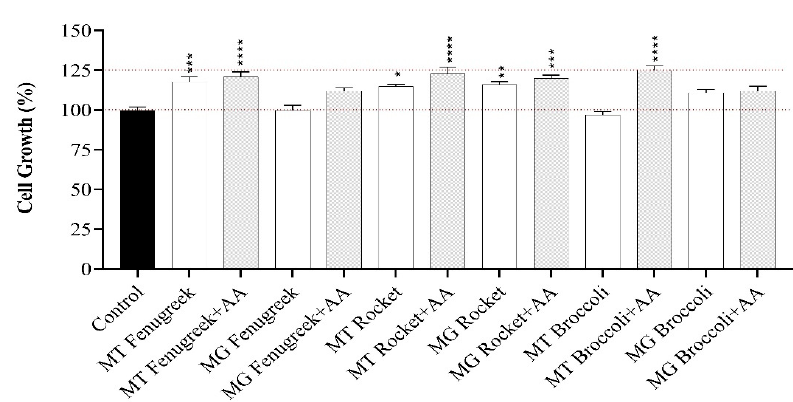
Figure 1. Cell viability of Caco-2 after exposure to digest vegetable Mature (MT) and Microgreen (MG) samples alone or with added ascorbic acid (AA) during digestion for 2 h. Results are presented as means ± SEM, n = 4. Data were analysed using a one-way ANOVA test. Different letters on top of bars indicate a significant difference: * ( p ≤ 0.05), ** ( p ≤ 0.01), *** ( p ≤ 0.001) and **** ( p ≤ 0.0001).